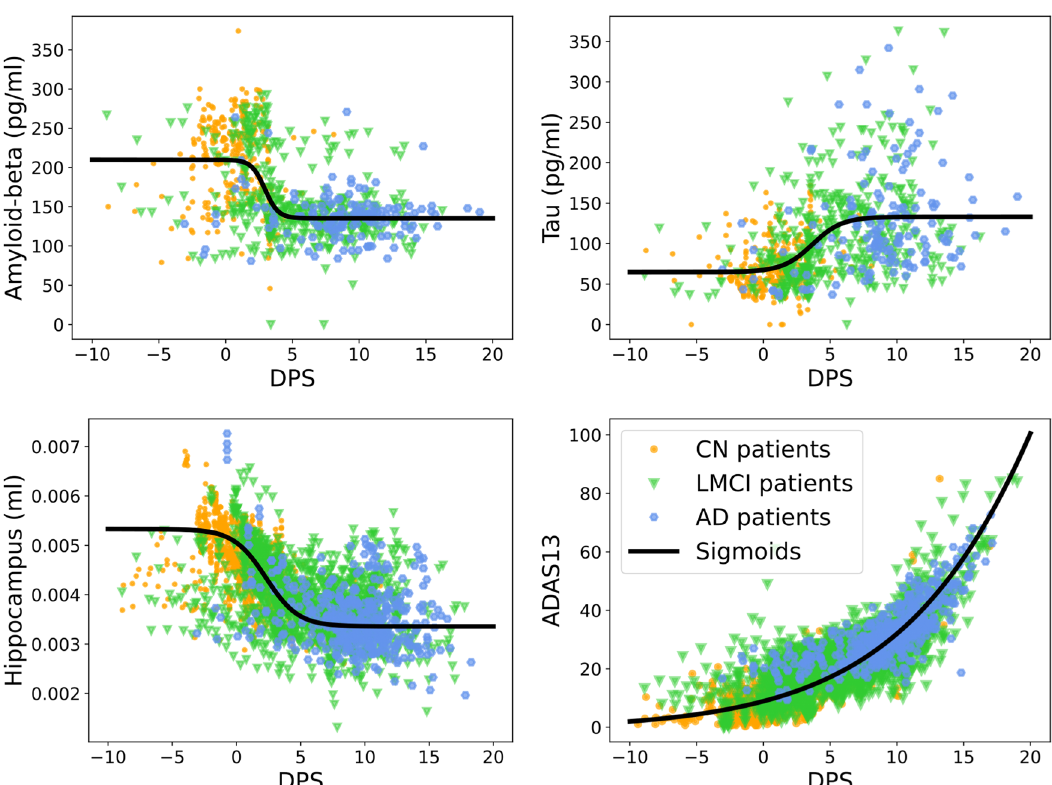
Fig. 2 Subject biomarkers in ADNI data and the fi tted sigmoid function. Top left is amyloid-beta; top right is the tau; bottom left is the normalized hippocampal volume; bottom right is the cognitive subscale. X-axes are fi tted DPS of biomarkers, and y-axes are the corresponding magnitudes of each biomarker. The subjects are classi fi ed into “ CN ” , “ LMCI ” , and “ AD ” according to ADNI diagnostic groups, where orange is “ CN ” , green is “ LMCI ” , and blue is “ AD ” . The black solid lines are fi tted with sigmoid functions 28